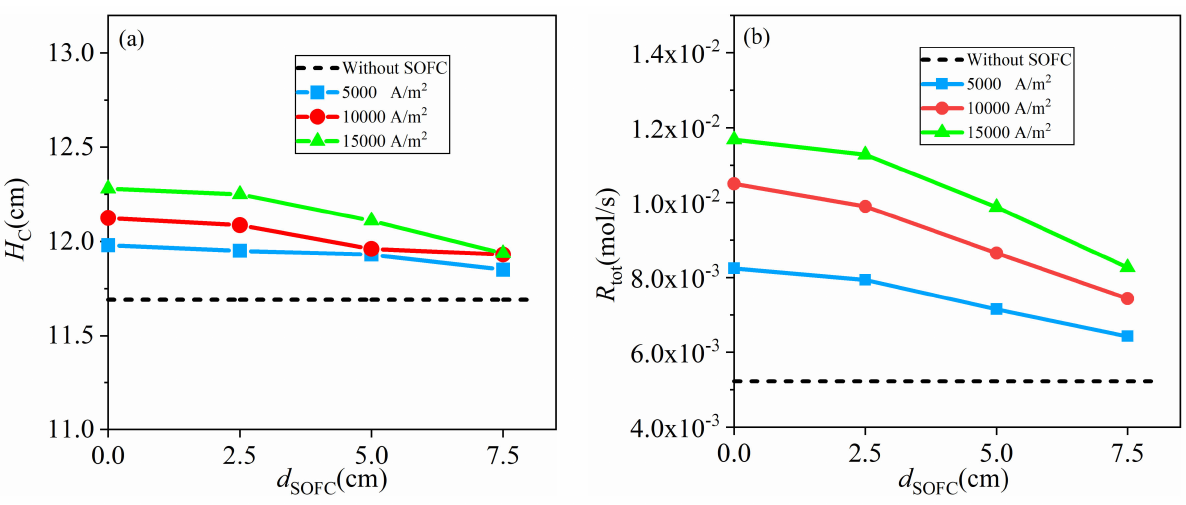
Figure 14. ( a ) Carbon bed height, H C and ( b ) total gasification rate, R tot of bubbling bed gasifiers coupled with SOFC with A s = 7.2 × 10 − 5 mol/m 2 , v CO = 1.5 2 ,in